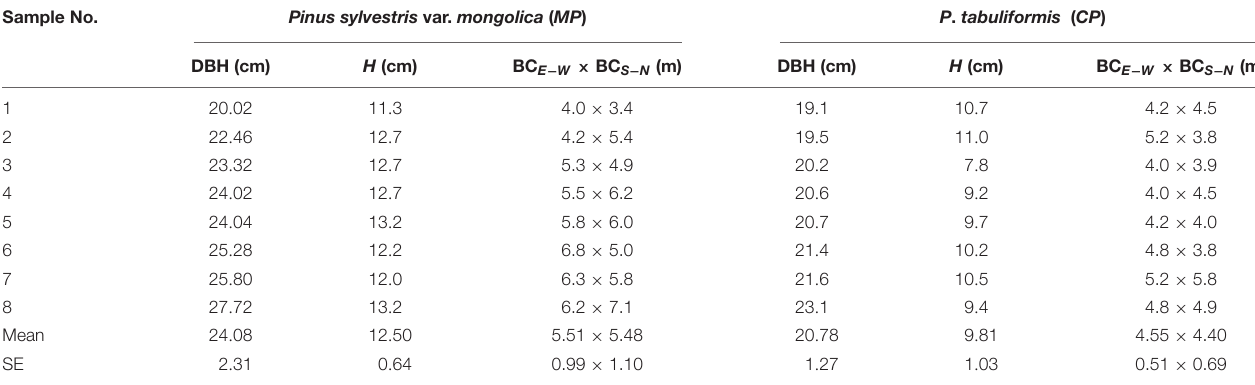
TABLE 1 | Diameter at breast height (DBH), tree height ( H ), crown width east-west (BC E − W ), and south-north (BC S − N ) for all sap flow-measured trees in sampled in 2013. Sample No. Pinus sylvestris var. mongolica ( MP